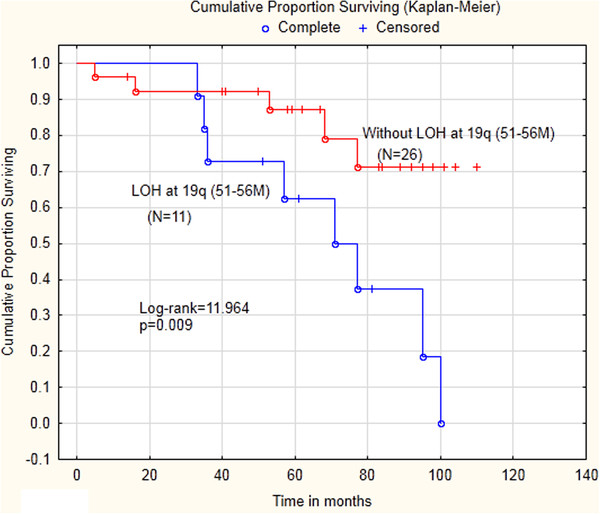
Patients with LOH at chromosome 19q (51-56 Mbp) are associated with shorter survival. Kaplan-Meier plot indicates significant differences in overall survival between patientis with and without LOH on chromosome 19q, Log-rank test =12.0; (p < 0.009).